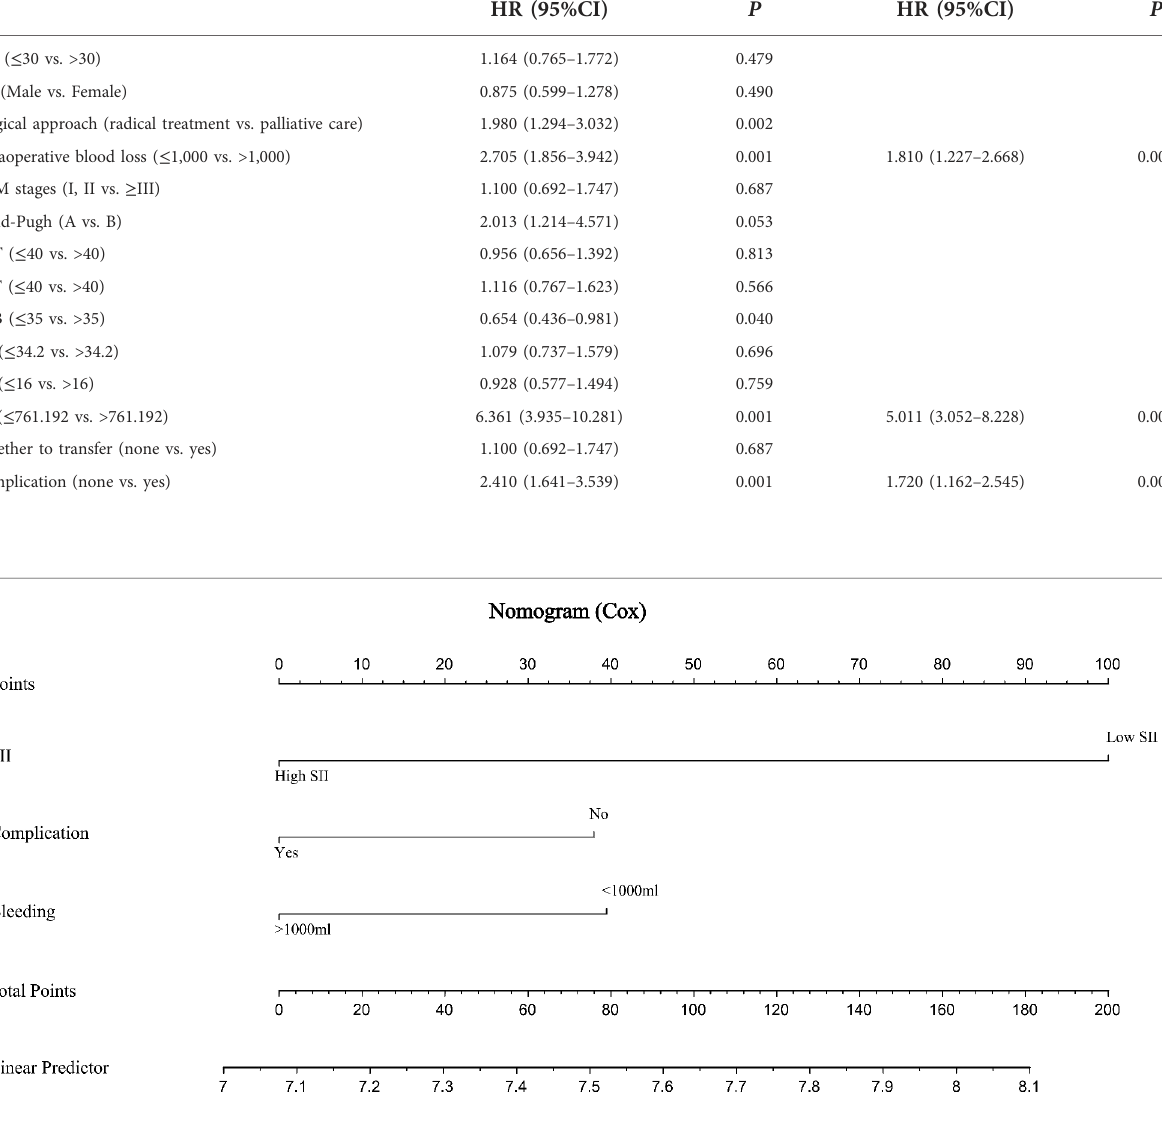
model has good discriminative power. The calibration curve also performed well in the validation set, as shown in Figure 5 .